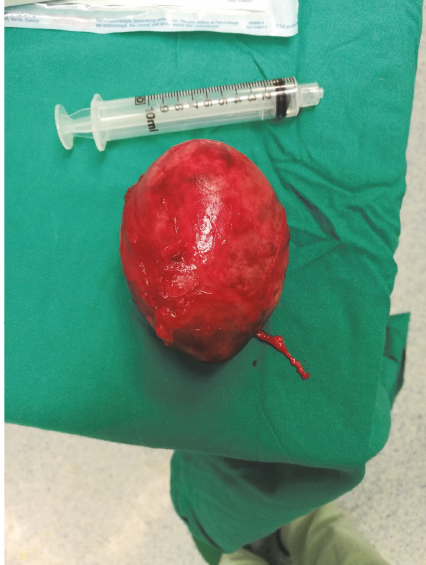
Figure 2: The excised mass had well-circumscribed smooth borders and rubbery consistency. It is covered by a thin and focally congested membrane. It weighs 157g and measures 7.5cm x 5.5cm x 5.5cm. Cut surface shows unilocular cystic mass filled with beige brown soft material and hair